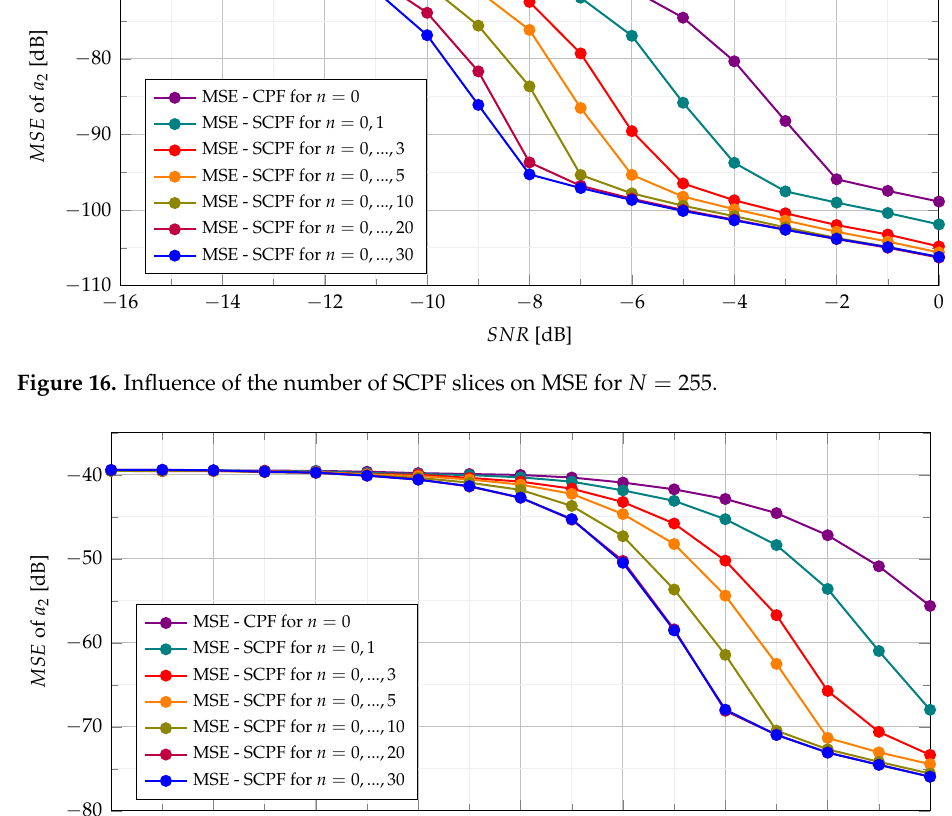
Figure 18. Probability of detection with use of the TSCPF statistics employing slices n = for N = 255.